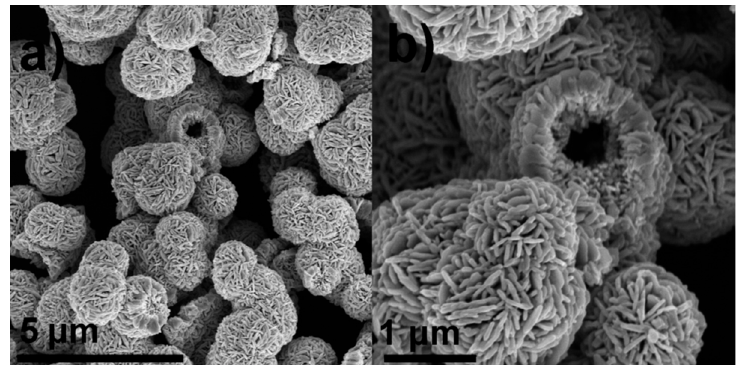
Figure 5. SEM image of WO 3 hollow microspheres when the resolution is: ( a ) 5 µ m and ( b ) 1 µ m [50].